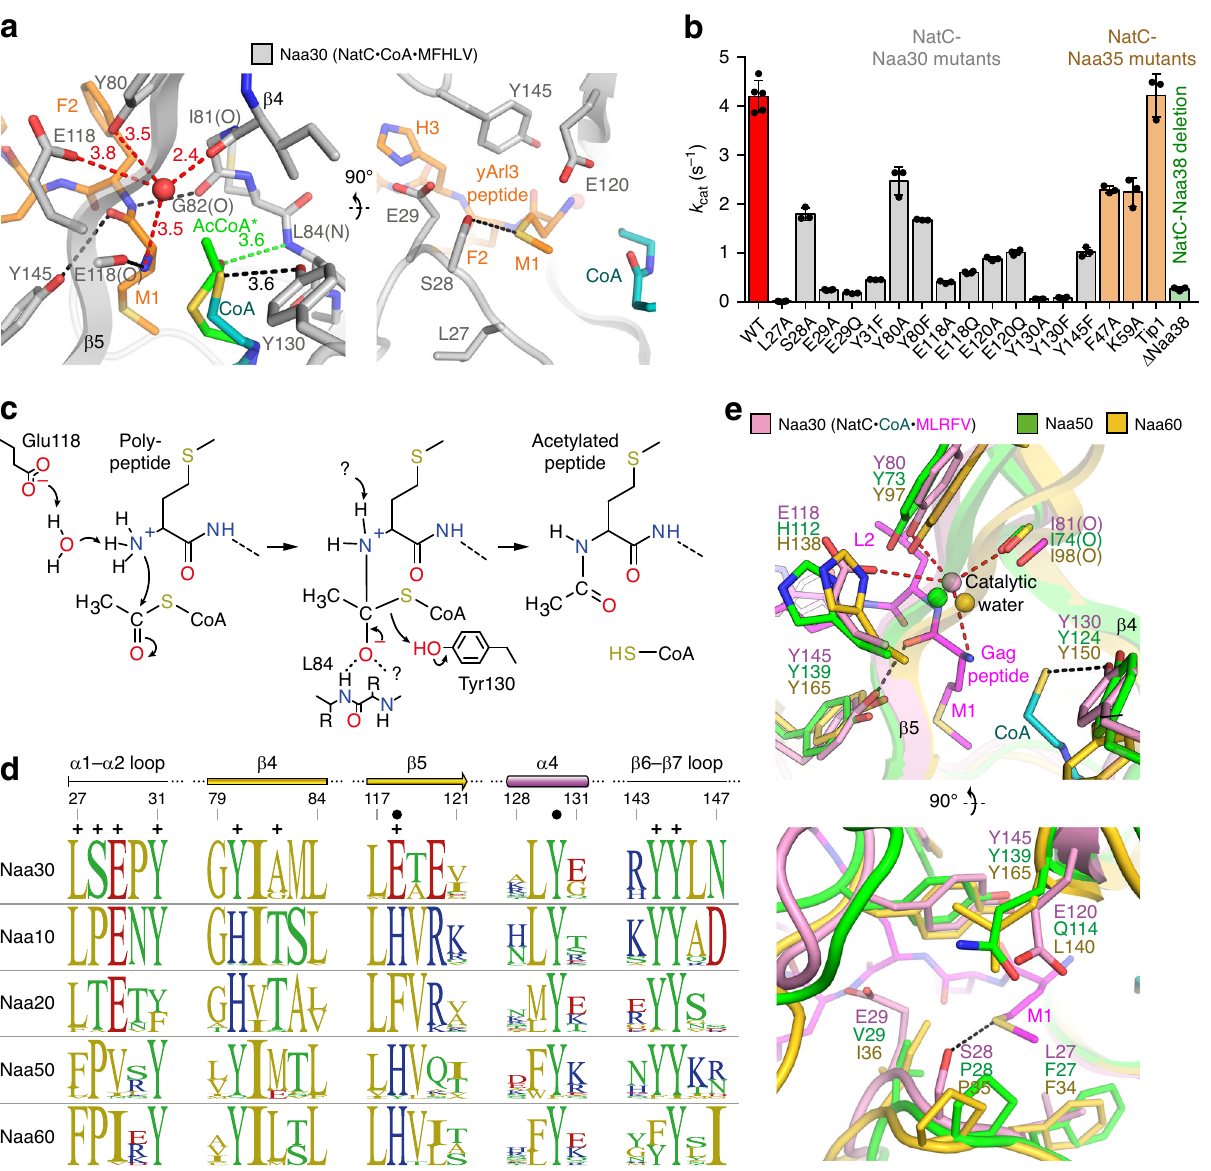
Fig. 4 Proposed catalytic mechanism for the NatC complex. a The active site of the NatC complex in NatC • CoA • MFHLV. The proposed catalytic water is indicated by a red sphere. The position of acetyl-CoA (green) was modeled based on a superposition of the Ard1 • Acetyl-CoA structure (4LX9) with Naa30. b Turnover numbers ( k cat ) of NatC WT and NatC mutants with the yArl3 substrate peptide. Data represent mean ± SD of independent experiments. The number of repetitions is provided in Table 2. c Proposed catalytic mechanism for the NatC complex (see discussion). d Sequence logos of regions near the active site, generated from multiple sequence alignments of 18 different species (see “ Methods ” ). Black circles indicate proposed catalytic residues and + signs, substrate-binding residues. e Superposition of NatC • CoA • MLRFV, Naa50 • CoA-Ac-MGLP (3TFY) and Naa60 • CoA-Ac-MKAV (5ICV). For simplicity, only NatC ligands are shown. The proposed catalytic water (sphere) is indicated in all